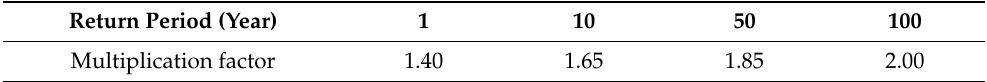
Table 3. Multiplication factors as a result of return